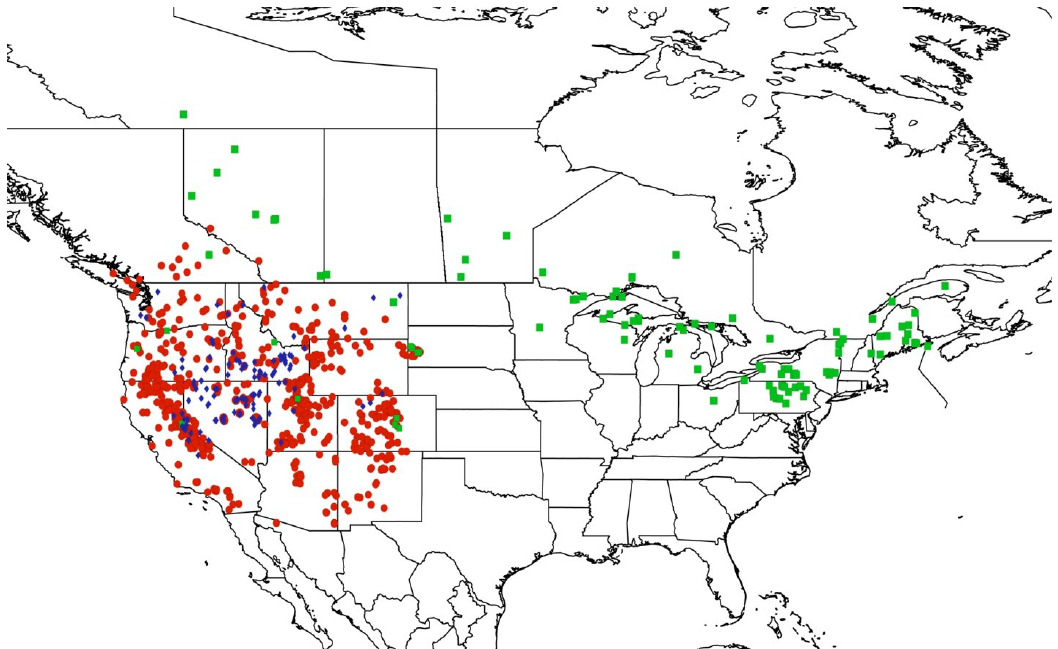
Figure 48. Distribution of Okanagana canadensis (green squares), O. bella (red circles) and O. annulata (blue